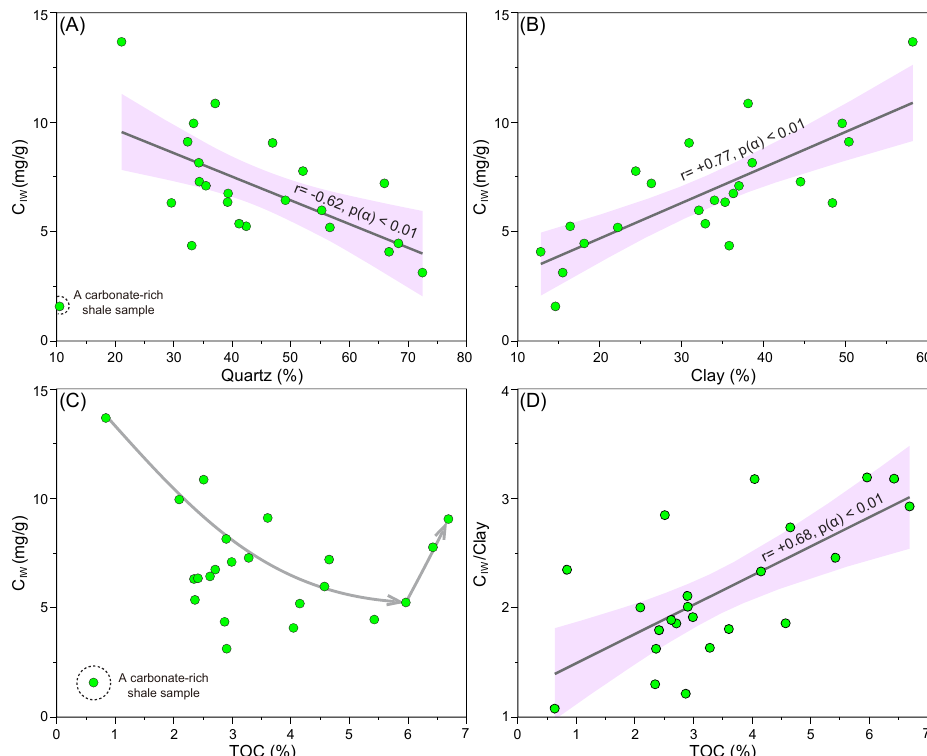
Figure 7. Cross-plots of the C IW value versus ( A ) quartz content, ( B ) clay content, ( C ) TOC content, and ( D ) C IW /clay ratio of the studied WF–LMX shales from the Well PS1. Regression lines (solid) with 95% confidence intervals (pink and grey zones) are shown.